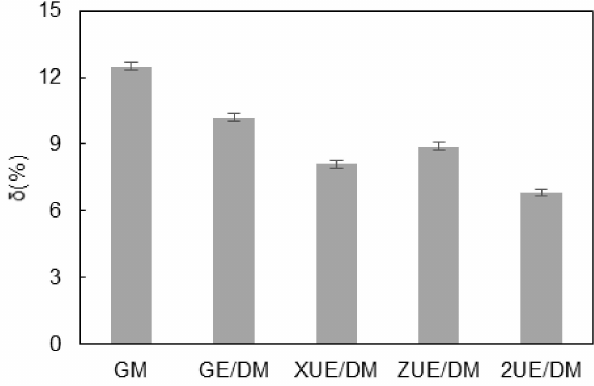
Figure 10. Comparison of form